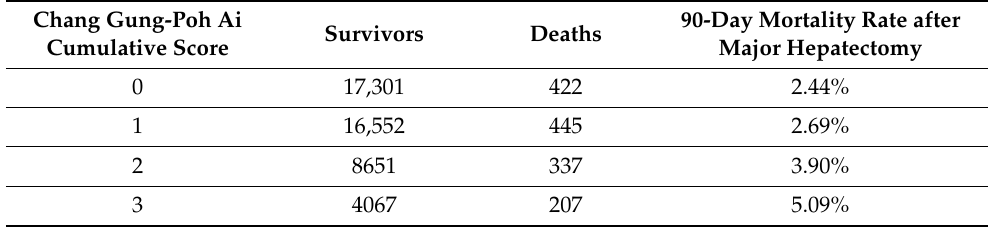
Table 4. All-Cause 90-Day Mortality Assessment Using Taiwan-Major Hepatectomy Mortality Predic- tive Scoring System for Hepatocellular